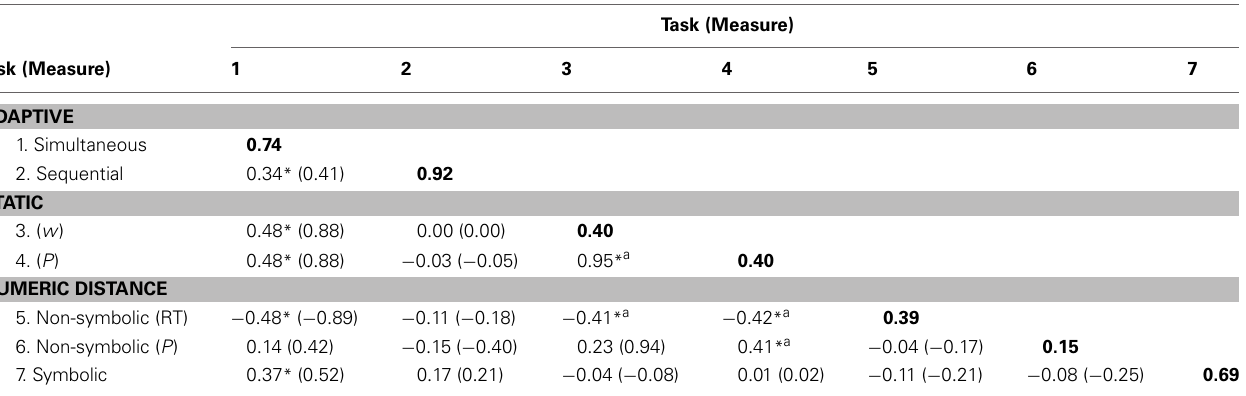
Table 2 | Pairwise correlations between proposed measures of ANS capacity.